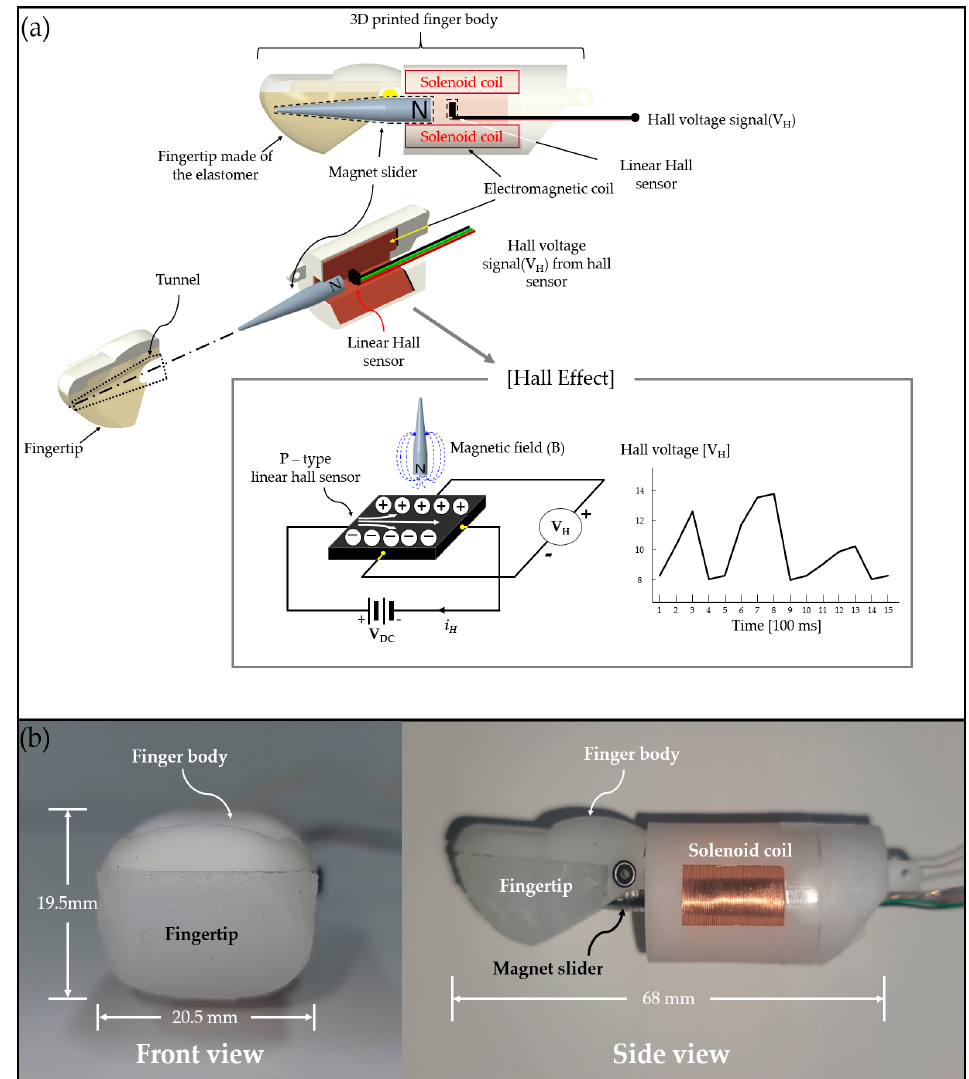
Figure 2. ( a ) Simplified exploded view of the proposed OFP sensor. ( b ) Images showing the fabricated OFP sensor. As shown here, the magnet slider is designed to be cone-shaped with a slippery surface coating. Thus, it can easily move in a horizontal direction on the application of an external force to the fingertip surface. The OFP sensor includes a P-type linear Hall sensor generating a Hall voltage (V H ), due to the Hall effect [48], activated by a magnetic field from the magnet